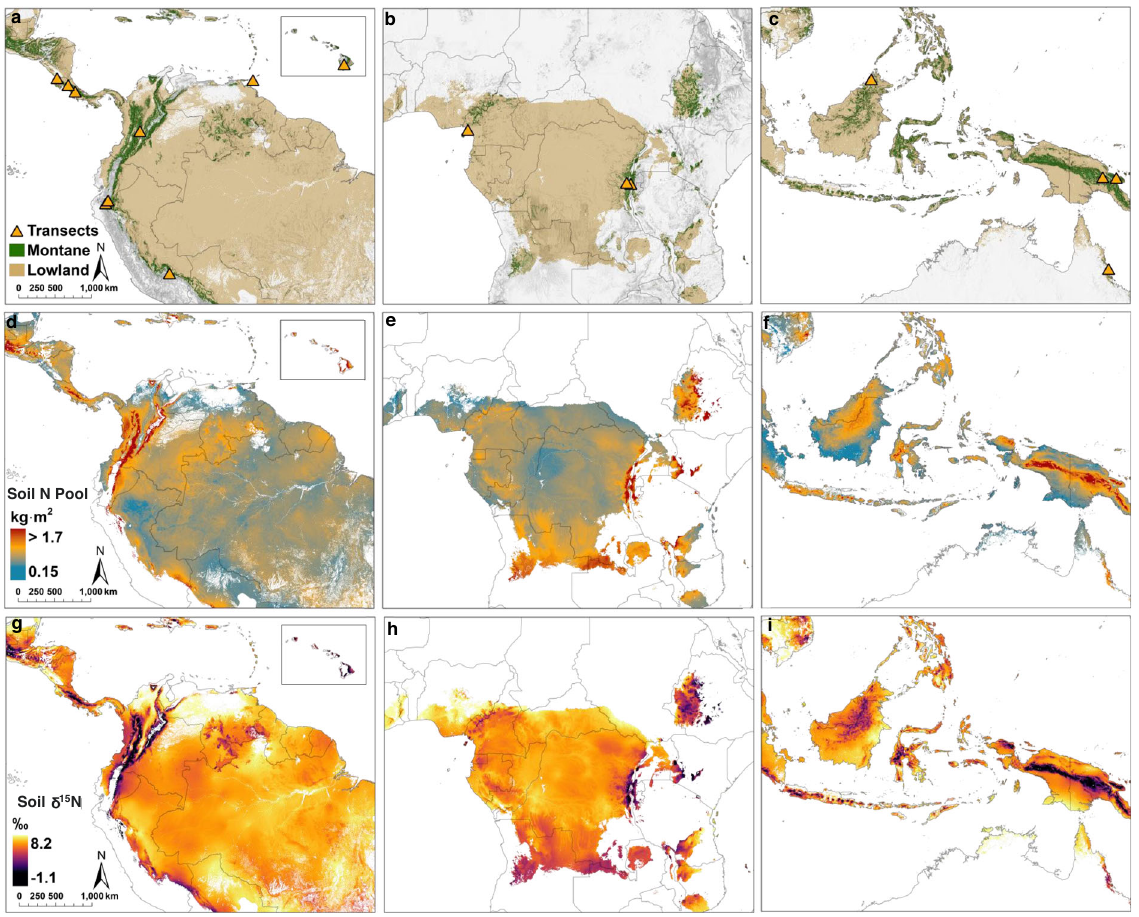
Fig. 1 | Global distribution of tropical montane forests, soil N pools, and δ 15 N. Extent of montane and lowland tropical forests and locations of elevational gra- dient transects ( a – c ). The distribution of surface mineral soil (0 – 20cm) N pools ( d – f ) and δ 15 N ( g – i ) based on linearmixed-effect models (Supplementary Table 4).